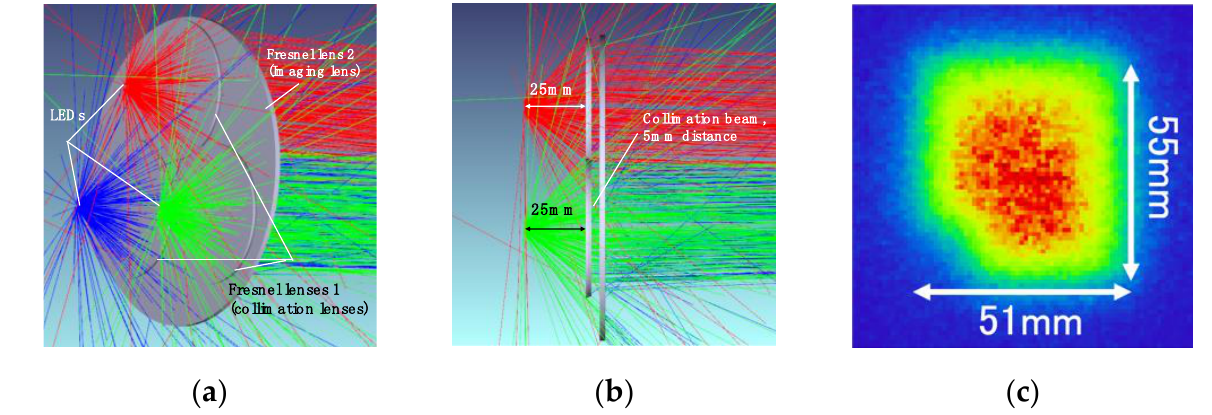
Figure 6. Simulation of the improved LED-OWPT system: ( a ) view from LED chip, ( b ) view from the side; and ( c ) irradiation spot at 1 m.